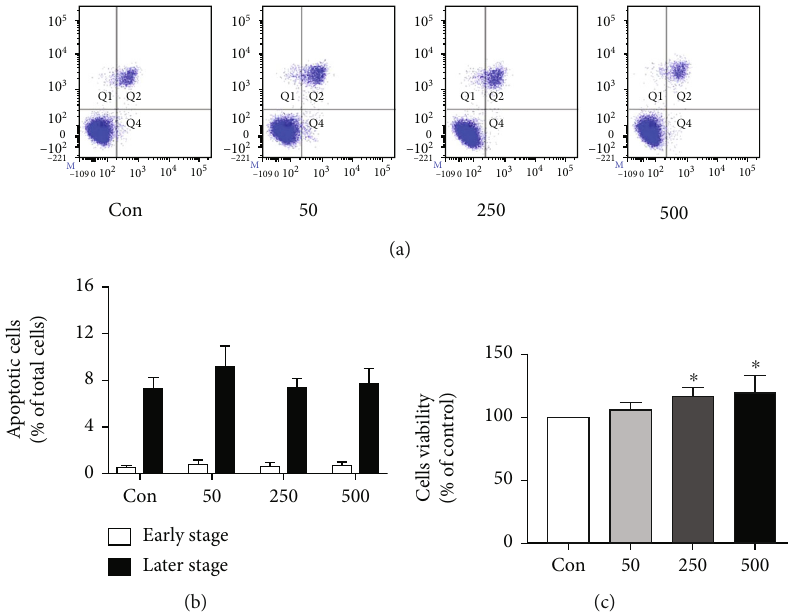
Figure 1: E ff ects of TMAO on proliferation and apoptosis in the HCT-116 cells. (a) Cell apoptosis assessed by fl ow cytometry. (b) Apoptotic rates in various groups. (c) Cell proliferation assessed with CCK-8. ∗ P < 0 : 05 versus Con group ( n = 5 ).